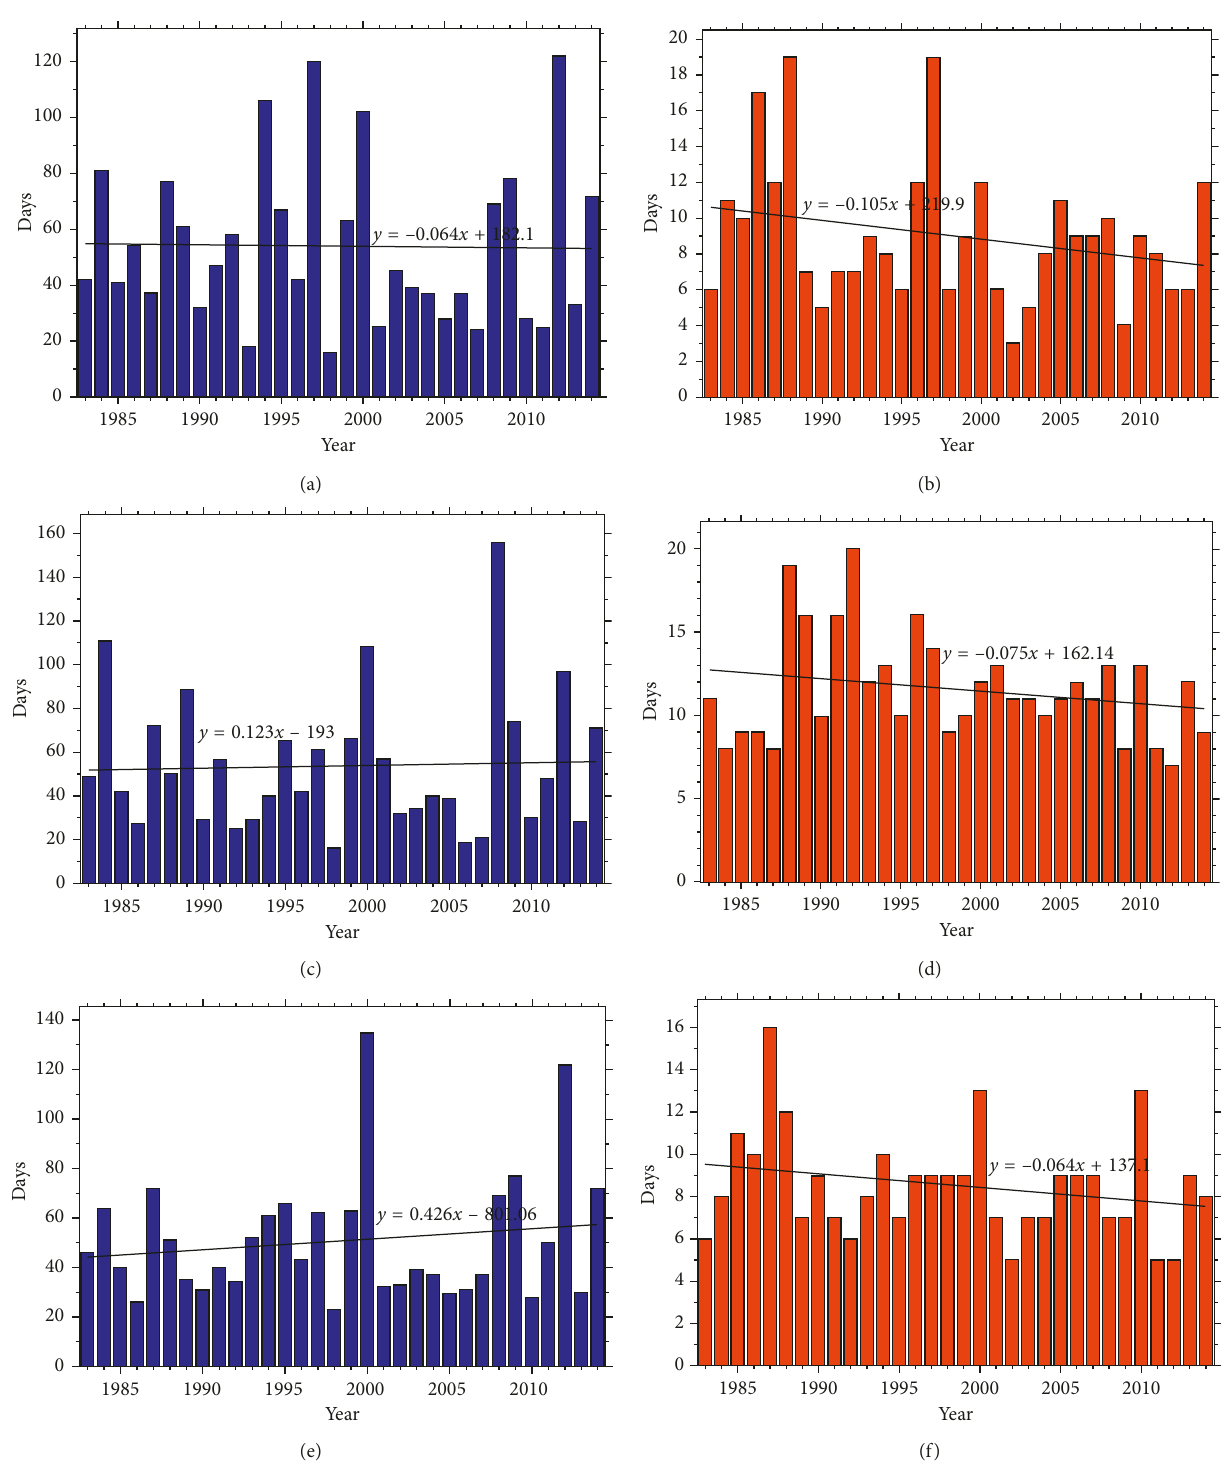
Figure 8: Trend of consecutive dry days (CDD) over three agroecological zones, (a) lowland, (c) midland, and (e) highland, and for consecutive wet days (CWD), (b) lowland, (d) midland, and (f) highland, for the period